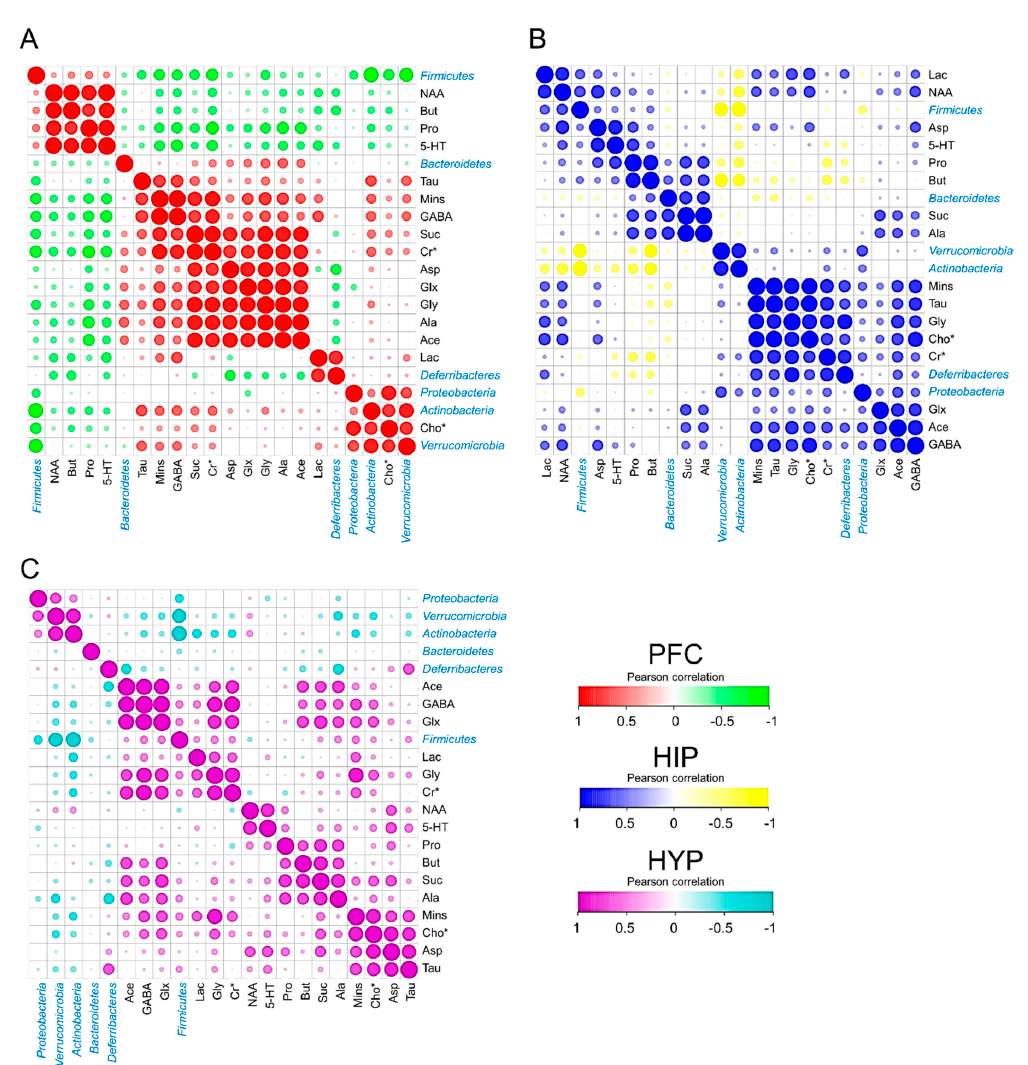
Figure 5. Cerebral metabolites correlated with the intestinal microbiota. ( A – C ) PFC ( A ), HIP ( B ), and HYP ( C ) metabolites correlated with intestinal microbiota (at the phylum level) in different treatment groups. Pearson correlation was used to calculate the correlation coefficient between cerebral metabolites and intestinal microbiota ( n = 3). All the raw data were standardized from 0 to 1.